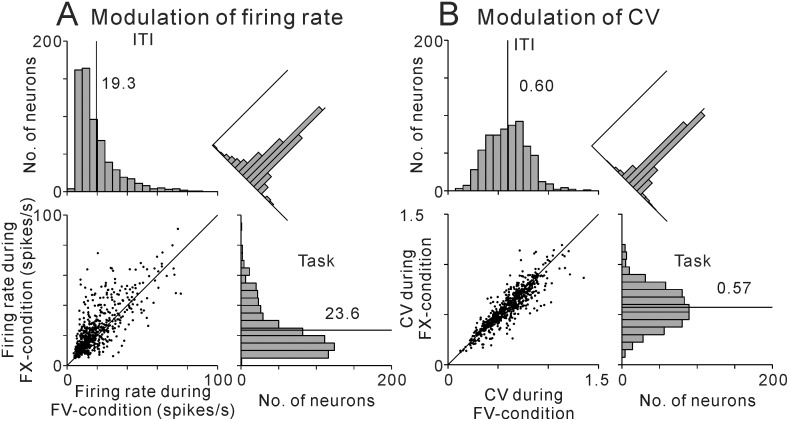
Distributions of firing rate and regularity of PPTN neuron.Summary histograms and scatter plots of the distributions of firing rate (A) and regularity (B) of PPTN neuron firing during the FX- (right) and FV-conditions (top).